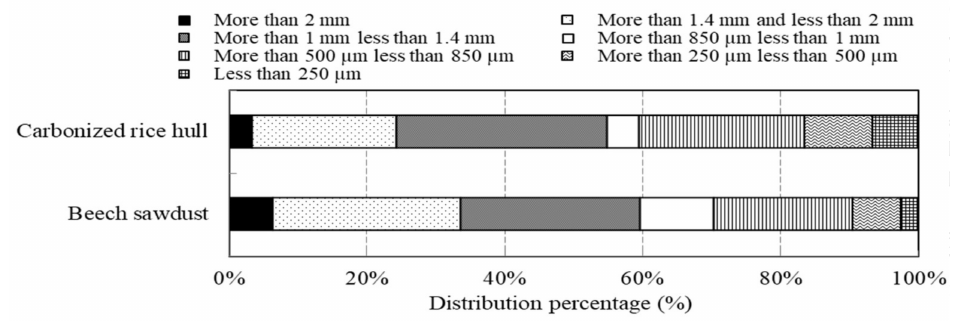
Figure 2. Particle size distribution of carbonized rice hull and beech sawdust.